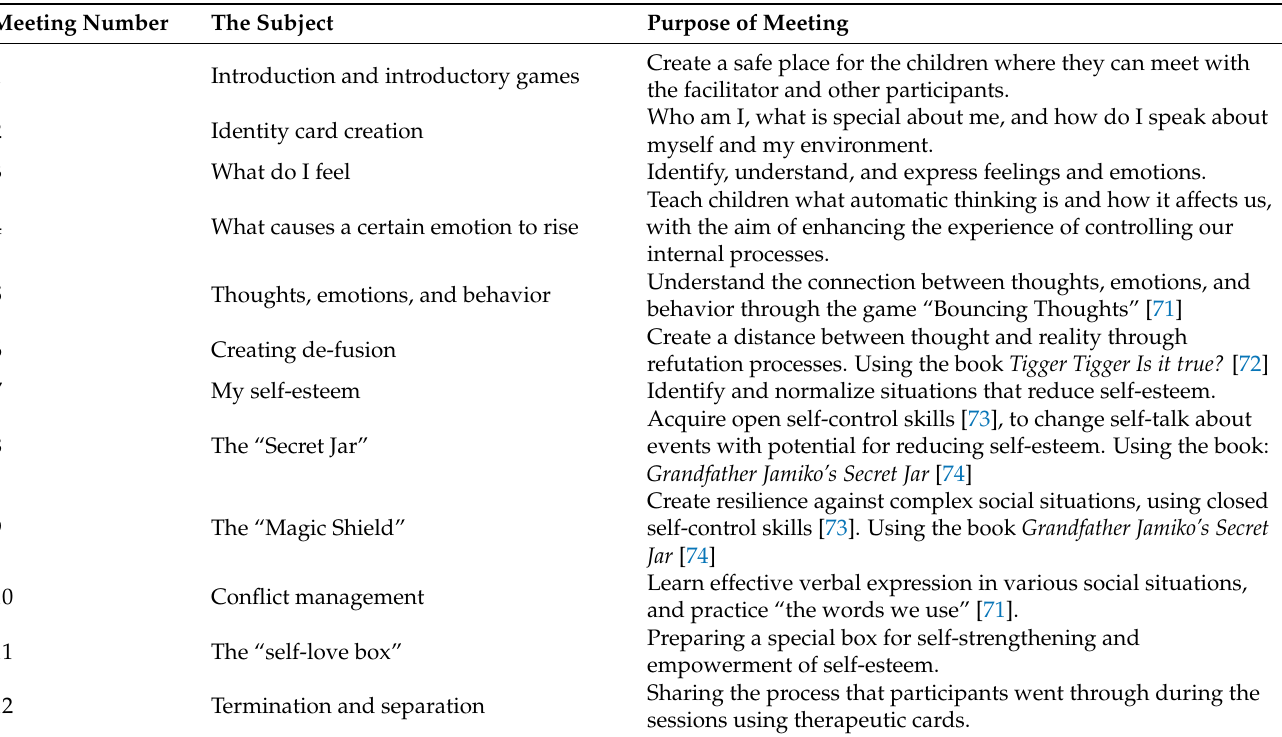
Table 1. Outline of the